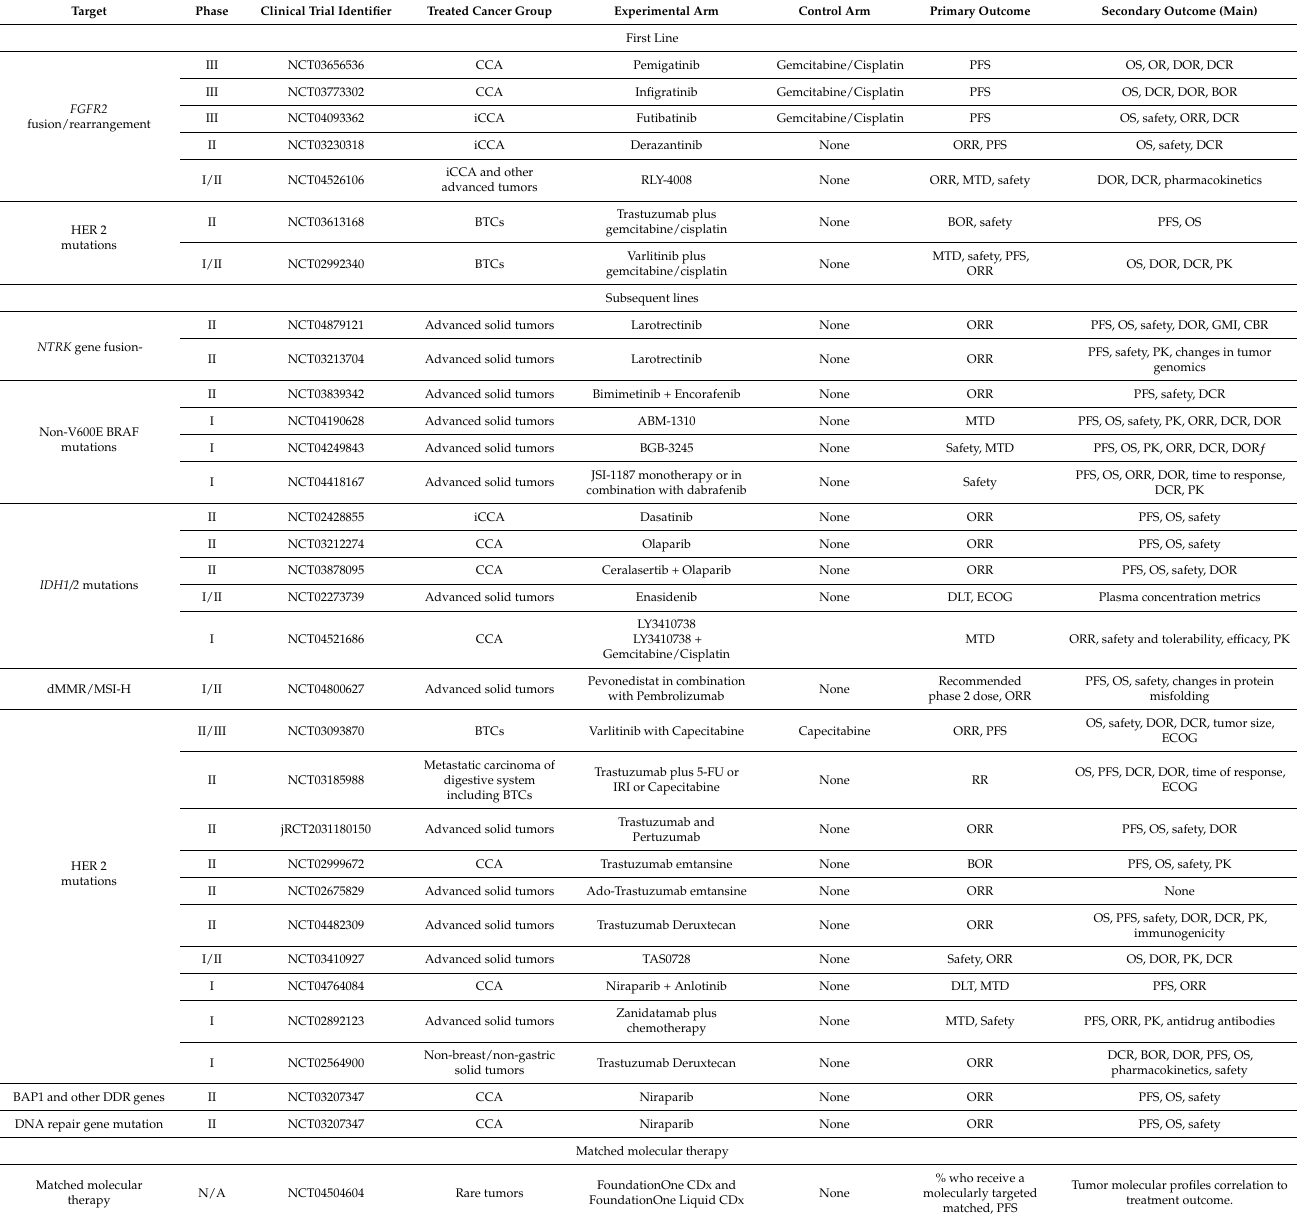
Table 3. Examples of ongoing trials in